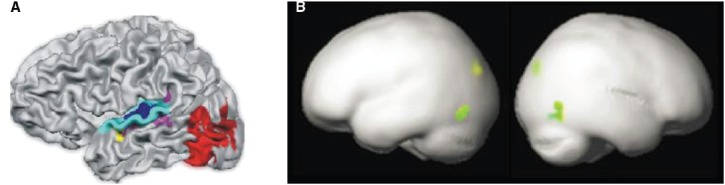
(A) Letter–sound association area (in blue) and VWFA (in red) in the left STS-STG (adapted from Blomert, 2011, Figure 1). (B) GraphoGame training effects (in green; adapted from Brem et al., 2010, Figure 2).